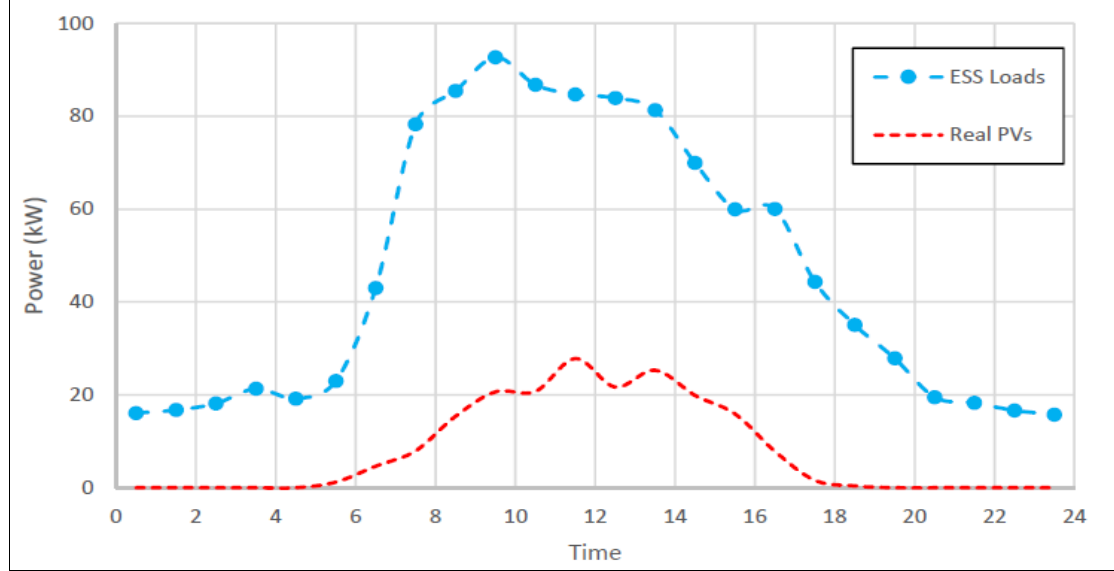
Figure 7. Essential load demand and PV generation during a scholastic day.